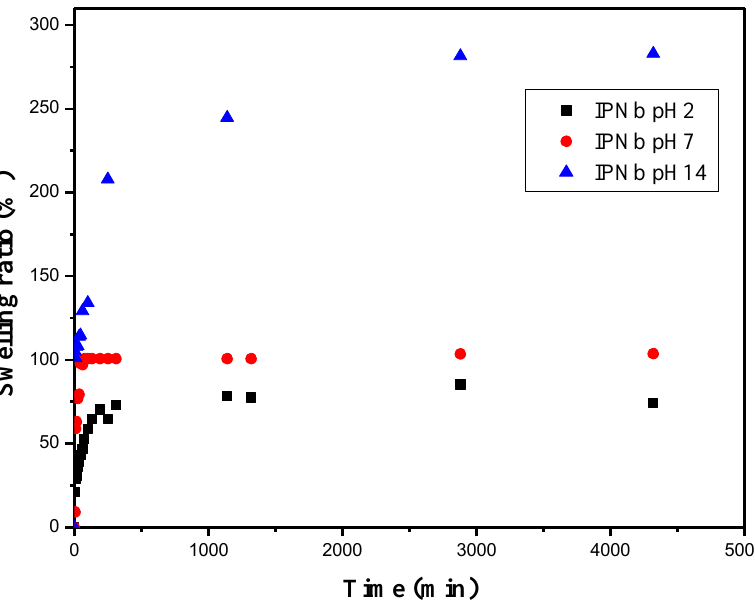
Figure 12. Swelling kinetic in water medium of the IPN b (ECH 7% and HEMA 200%), cellulose (ECH 7%) and PHEMA hydrogels.